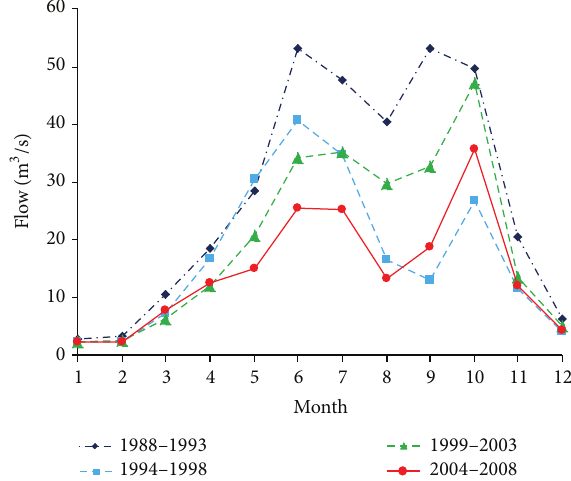
Figure 6: Monthly runoff distribution during 1988 to 2008 with a 4-year increment.